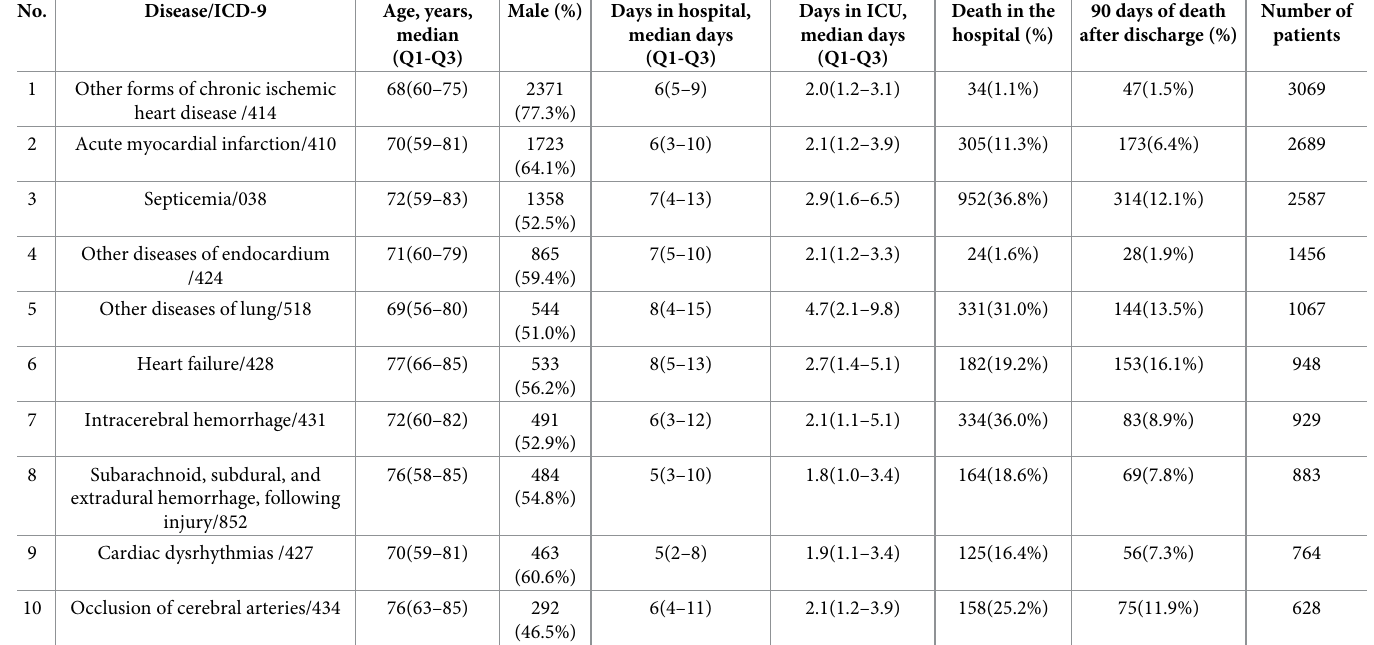
Table 2. Basic information of ten diseases with the largest number of